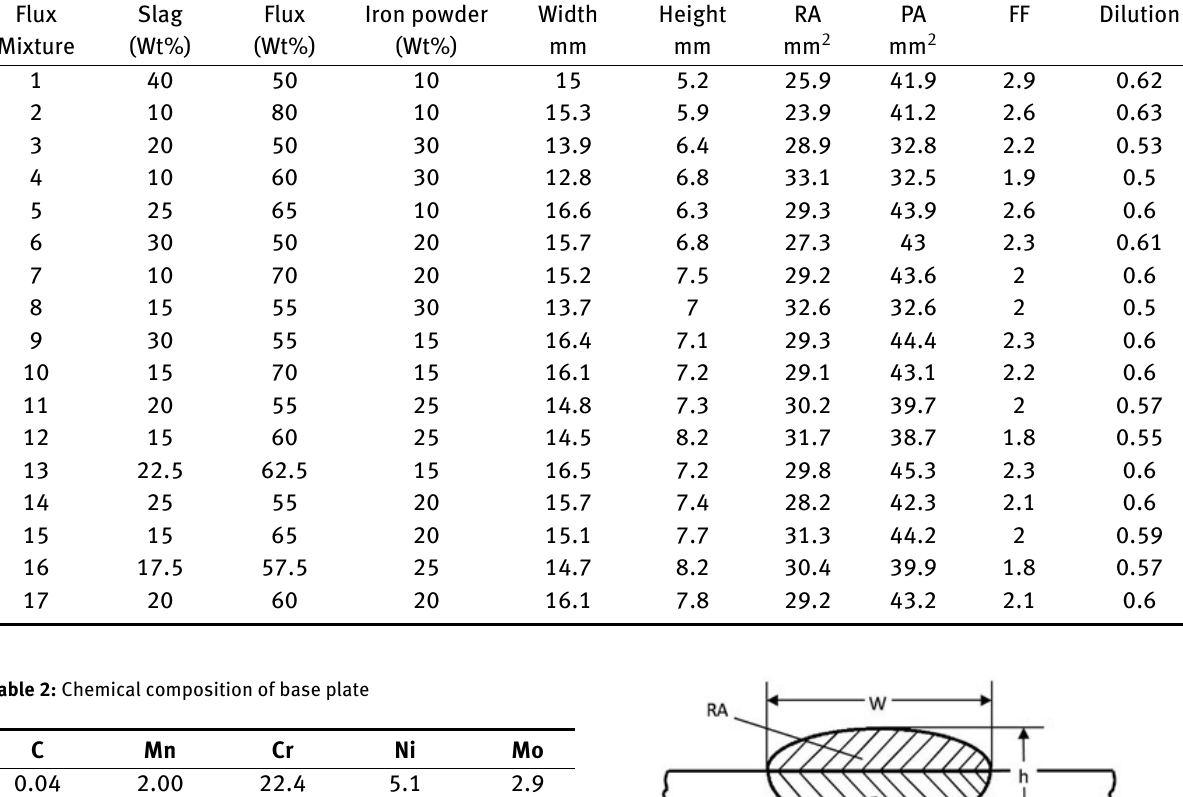
Table 1: DOE and results for weld bead characteristics Flux